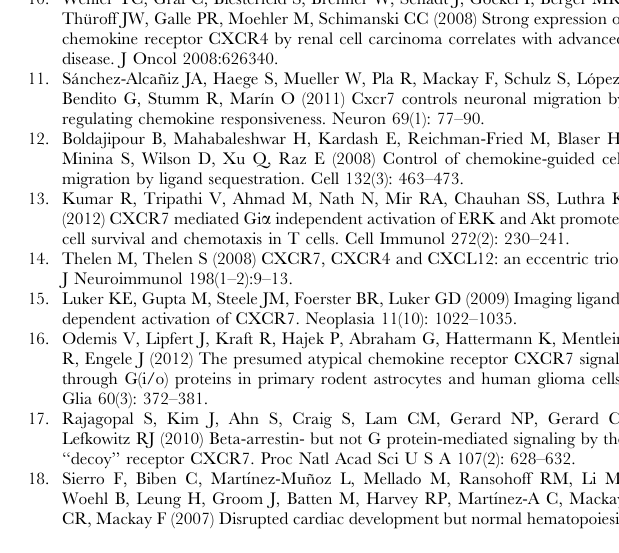
Figure S1 Expression of CXCR7-GFP in podocytes. Dual immunofluorescence for GFP and the podocyte marker nephrin in a kidney section of a E16.5 CXCR7-GFP BAC transgenic mouse demonstrates colocalization of GFP and nephrin. Scale bar equals 20 m m. Figure S2 Specific CXCR4-labeling by the UMB-2 anti- CXCR4 antibody. UMB-2 antibody was applied to kidney sections from E16.5 wildtype and CXCR4 knockout mice and detected by the 3-amino-9-ethyl-carbazole method. Sections were